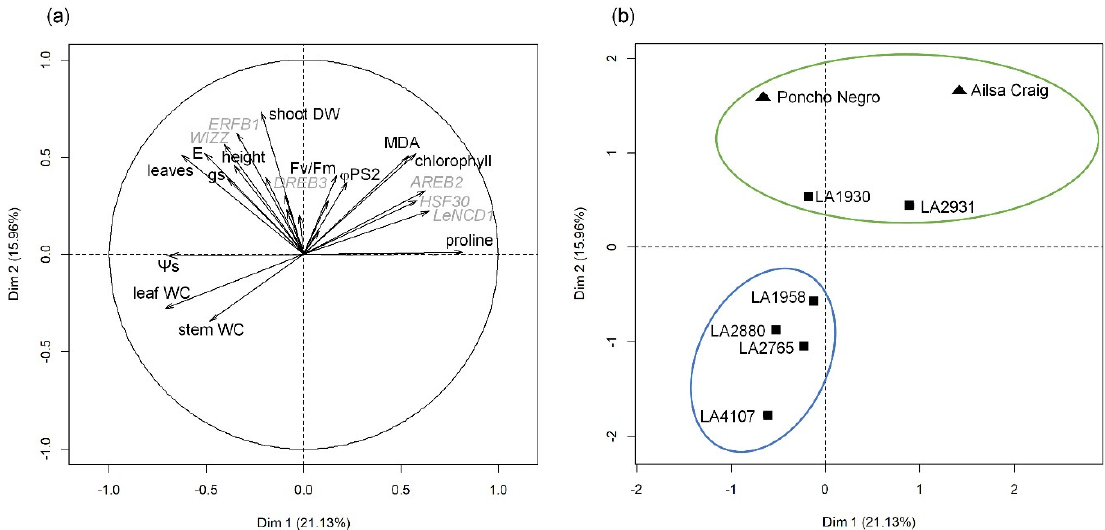
Figure 1. Principal component analysis (PCA) of growth parameters, physiological parameters, and gene expression of stress markers in S. lycopersicum and S. chilense subjected to two temperatures (21 ◦ C vs. 28 ◦ C) and water supply (well-watered vs. water-stressed) conditions. ( a ) Variable graph of PCA presenting growth and physiological parameters (black) and marker genes (grey); only significant parameters at p < 0.001 were included. ( b ) Individual graph presenting the accessions of S. chilense (square) and S. lycopersicum (triangle). Accessions were gathered in two groups. Dim 1 and Dim 2: dimension 1 and 2 of the PCA; DW: dry weight; gs: stomatal conductance; MDA: malondialdehyde; Ψ s: osmotic potential; ϕ PS2: efficiency of photosystem 2; WC: water content.